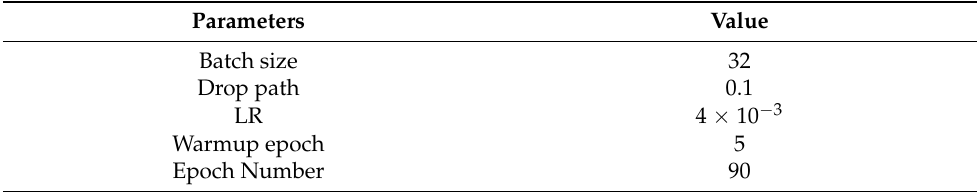
Table 1. The parameters of the RepLKNet model during the training phase. Parameters Value Batch size 32 Drop path 0.1 LR Warmup epoch Epoch